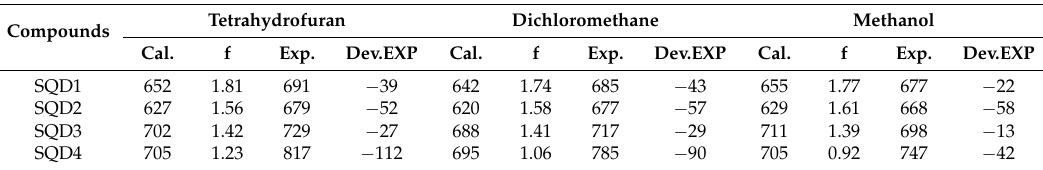
Table 2. Experimental and theoretical absorption wavelength (nm) by using PBE/6-311++G** for squaraine studied dyes in different solvents. Tetrahydrofuran Dichloromethane Methanol Compounds Cal. f Exp. Dev.EXP Cal. f Exp. Dev.EXP Cal. f Exp. Dev.EXP SQD1 652 1.81 691 − 39 642 702 627 1.56 679 − 52 620 1.58 677 − 57 629 1.61 668 − 58 SQD3 702 1.42 729 − 27 688 1.41